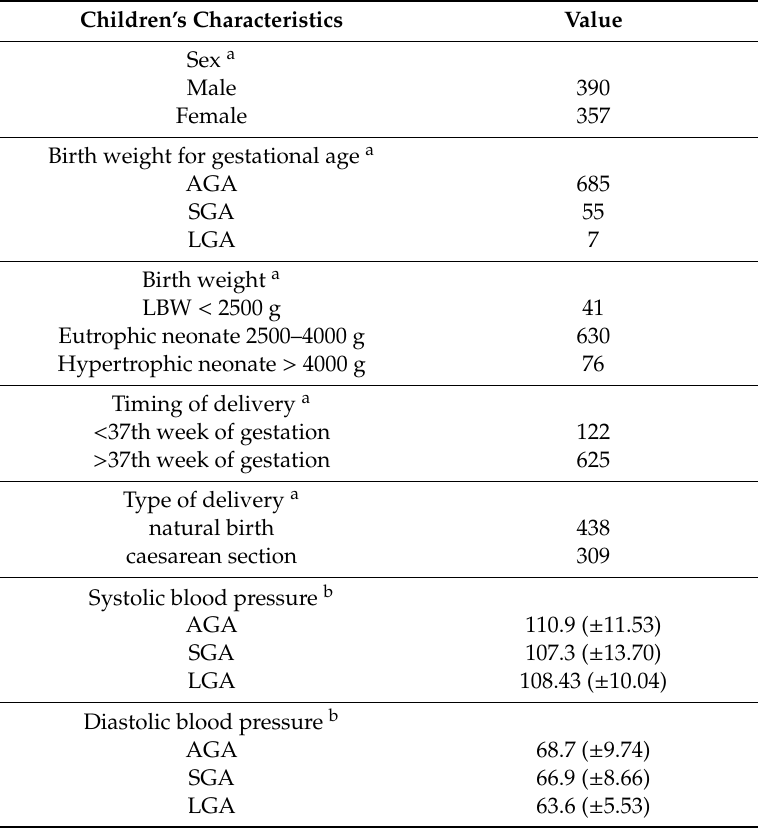
Table 1. Characteristics of perinatal parameters in the study group. LBW, low birth weight; AGA, appropriate weight for gestational age; SGA, small for gestational age; LGA, large for gestational age.